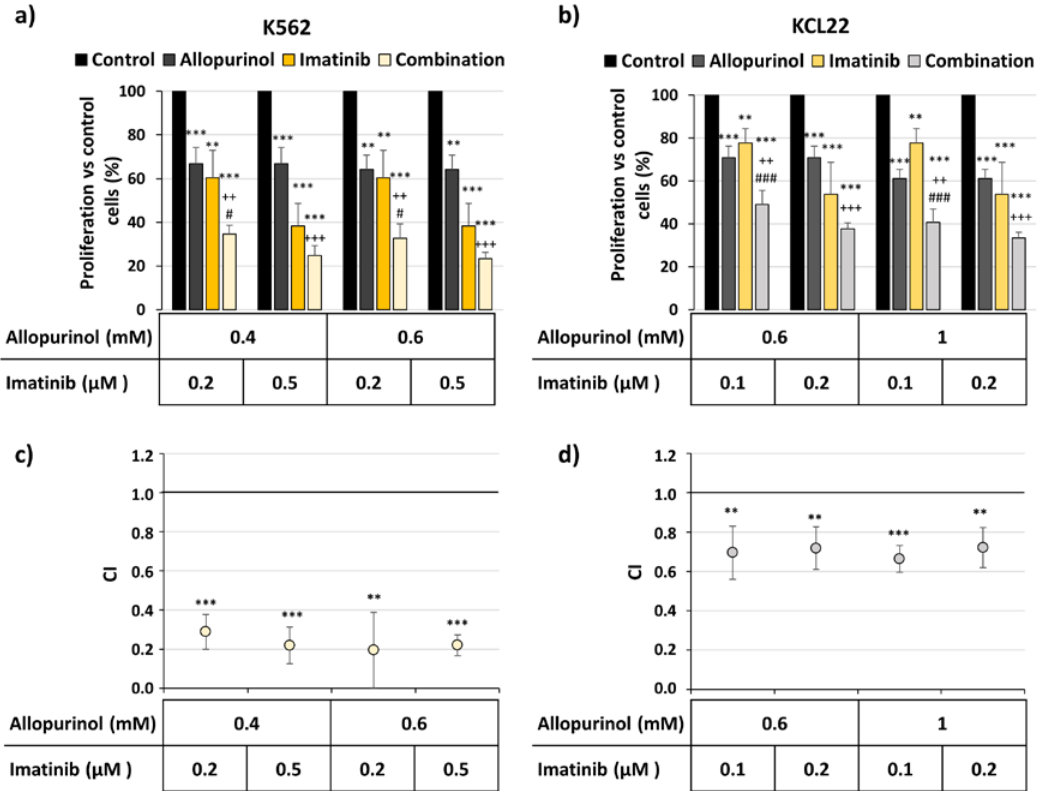
Figure 2. The combination of imatinib and allopurinol reduces the proliferation of the K562 and KCL22 cells in a synergistic manner. K562 and KCL22 cells were treated with di ff erent concentrations of imatinib, allopurinol or their combination for 48 h. Proliferation was analyzed by MTT assay and the combination indexes (CI) were calculated as described in the Methods section. ( a ) K562 cells proliferation with respect to control ( n = 4). ( b ) KCL22 cells proliferation with respect to control ( n = 5). Significant di ff erences: *** p < 0.001, ** p < 0.01 with respect to control; +++ p < 0.001, ++ p < 0.01 with respect to allopurinol-treated cells; ### p < 0.001, # p < 0.05 with respect to imatinib-treated cells. ( c ) Mean CI values for the drug combinations tested in K562 cells ( n = 4). ( d ) Mean CI values for the drug combinations tested in KCL22 cells ( n = 5). *** p < 0.001 and ** p < 0.01 reflect significant di ff erences with respect to CI value 1.